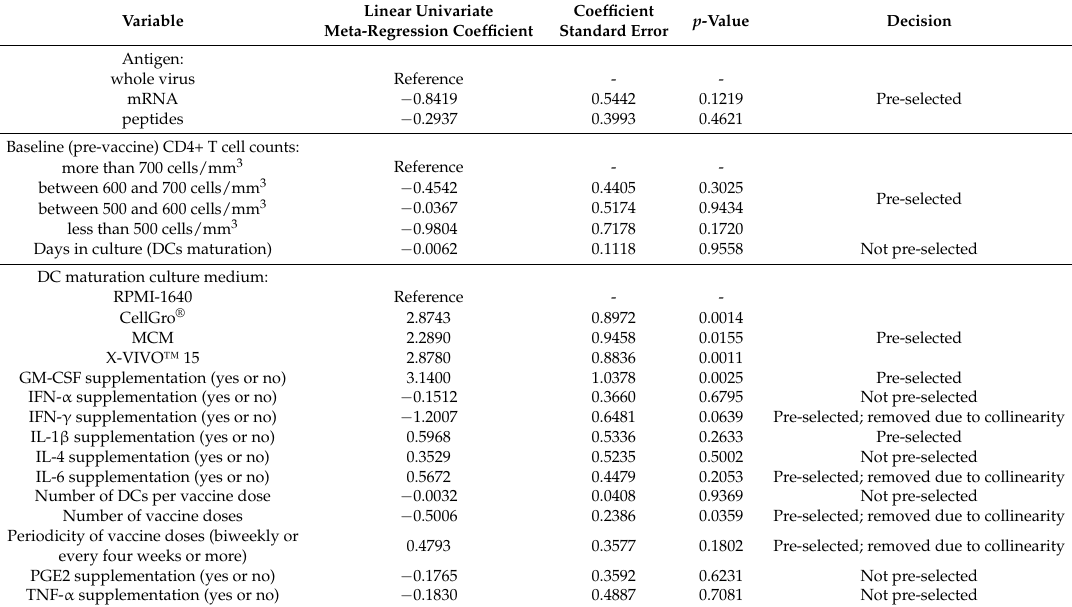
Table 5. Univariate analysis of factors and decision to include into multivariate analysis. The objective was to evaluate association with treatment success rate of dendritic cell-based experimental anti-HIV vaccines.